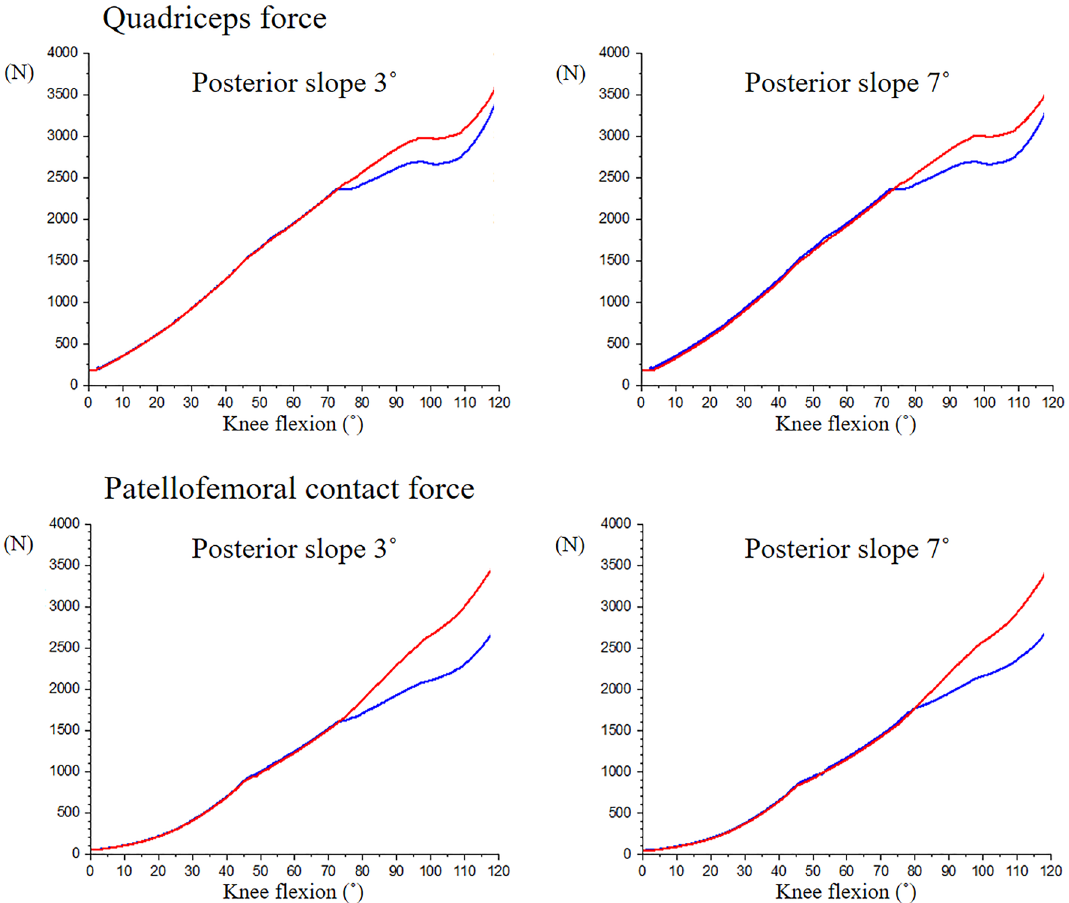
Figure 4. Quadriceps force and patellofemoral contact force of cruciate-retaining and posterior-stabilized design. Red: cruciate-retaining design, Blue: posterior-stabilized design.